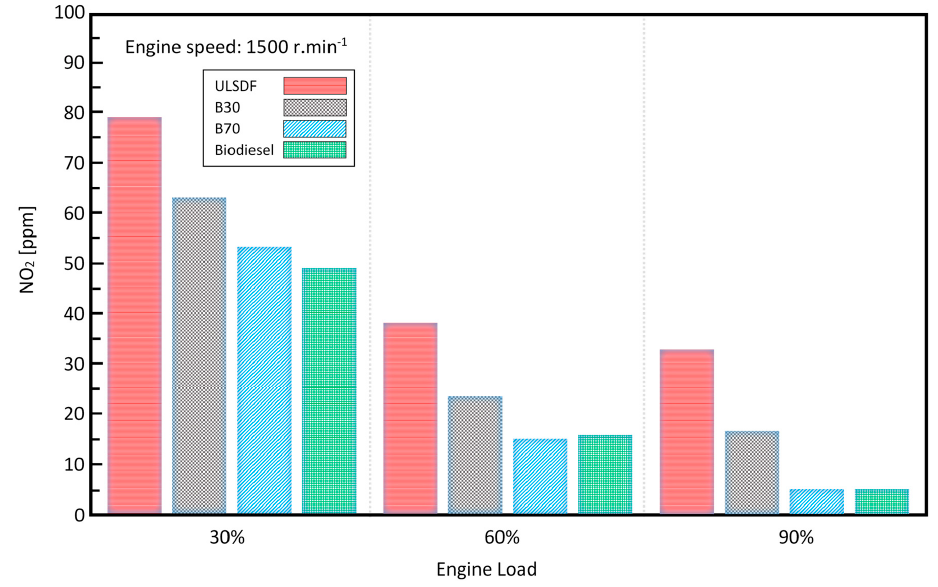
Figure 11. The dependence of testing fuels on the NO 2 emissions (1500 rpm).